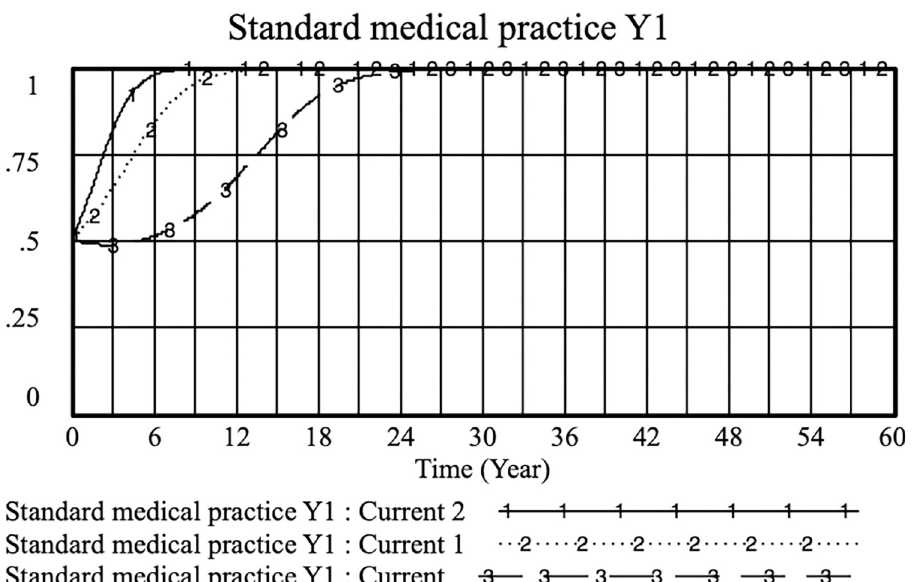
Fig 3. Effect of PE 1 on the physician standard medical practice strategy selection. (current: PE 1 = 0.4; current 1; PE 1 = 0.6 and current 2:PE 1 = 0.8).